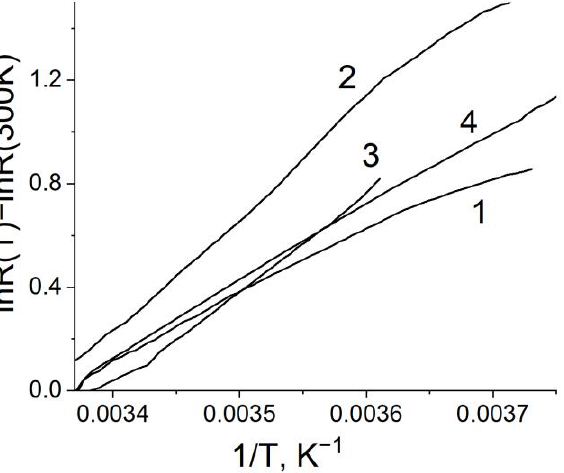
Figure 1. Dependence of logarithm of relative resistivity of 1 – 4 on reciprocal temperature.